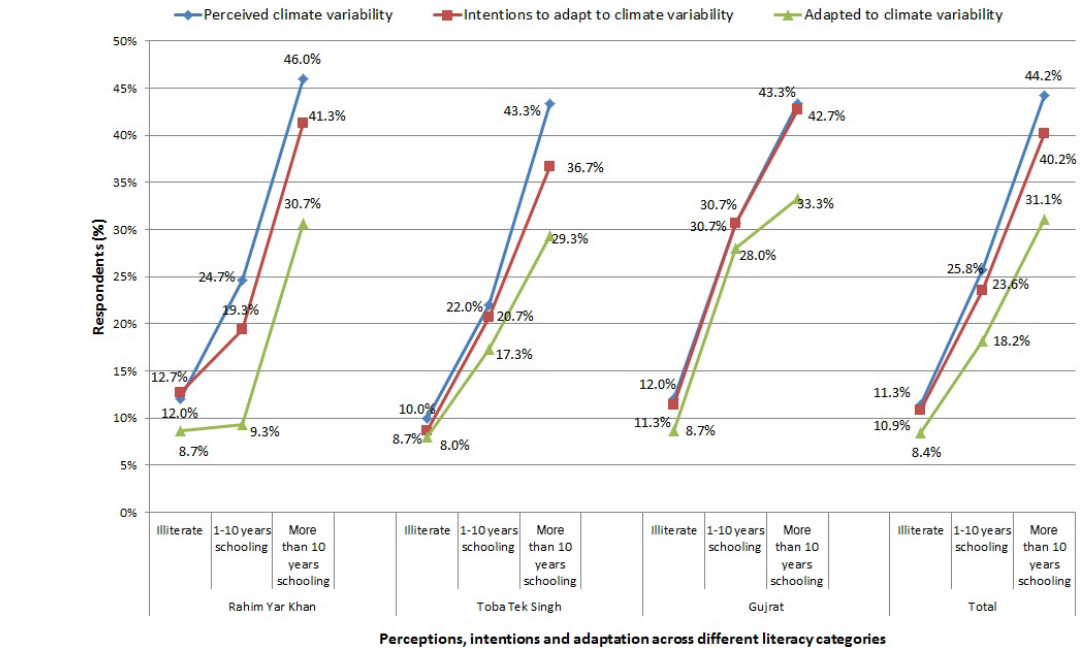
Figure 7. Adaptation to climate variability across different categories of farmers based on education level.